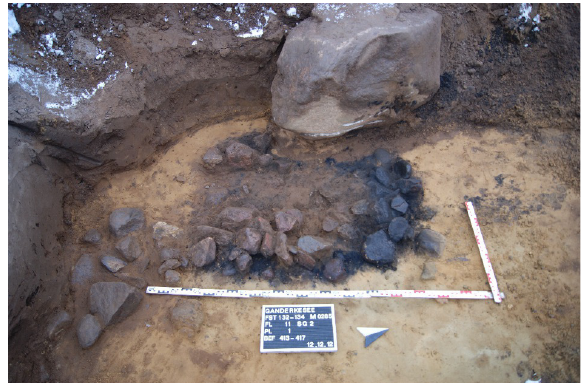
Figure 10: Numbered potential finding are cleaned for further inspection.